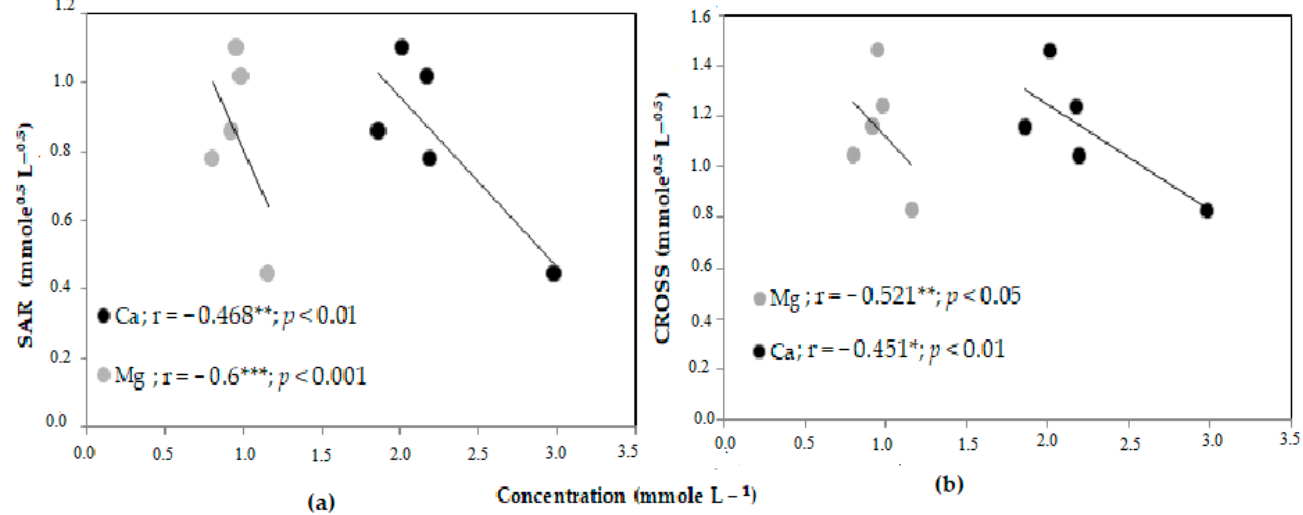
Figure 3. Linear regressions showing the relationship between calcium (Ca 2+ ) and magnesium (Mg 2+ ) concentrations for ( a ) sodium adsorption ratio (SAR) and ( b ) cation ratio of structural stability (CROSS). Cation concentrations, SAR, and CROSS are averaged across soils irrigated with treated wastewater and across all depths. *, **, *** Significant at p < 0.05, p < 0.01, and p < 0.001, respectively.